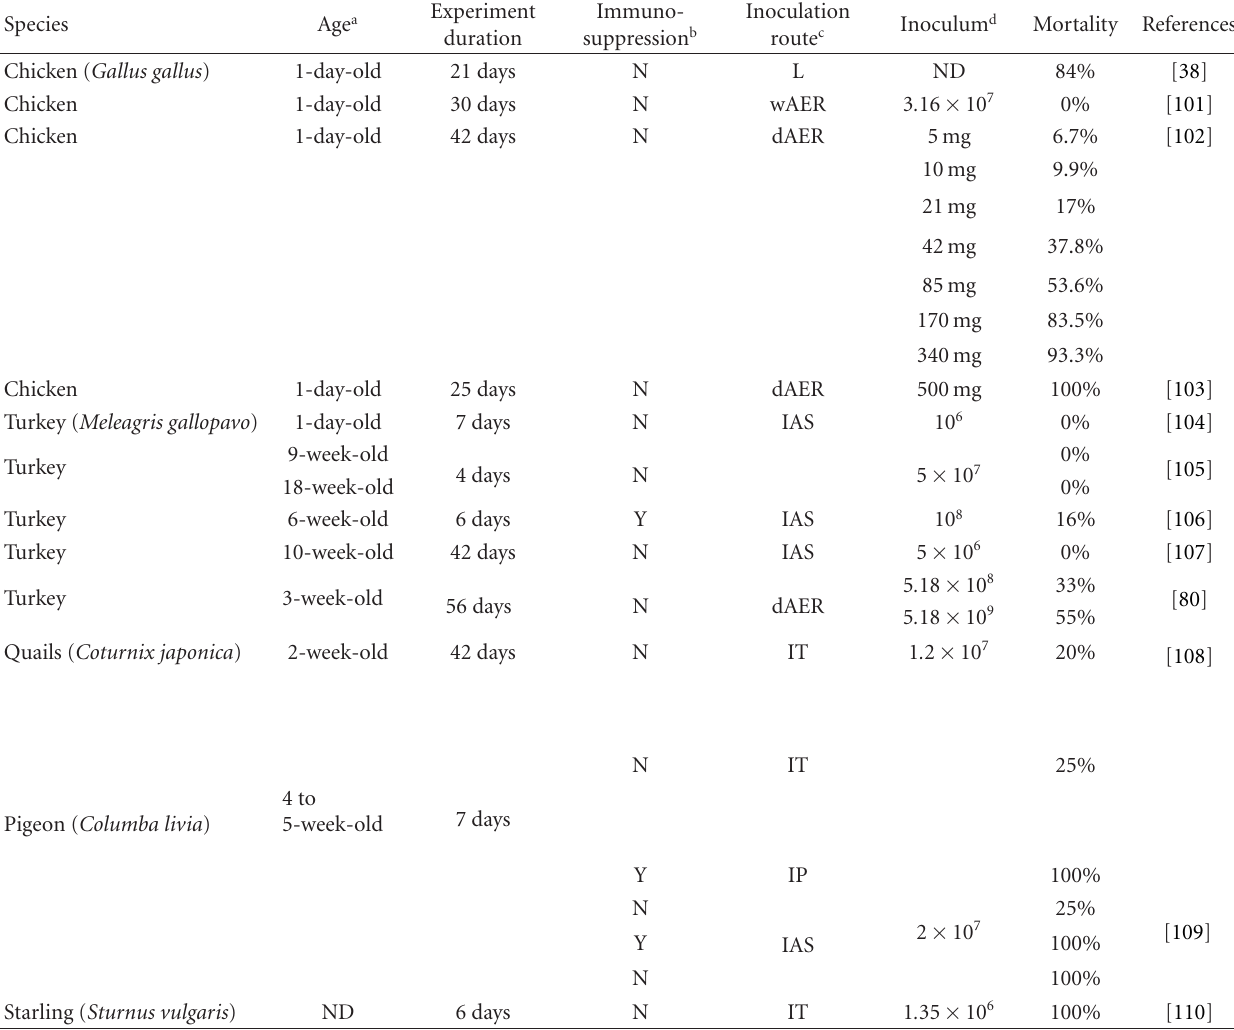
Table 1: Models of avian